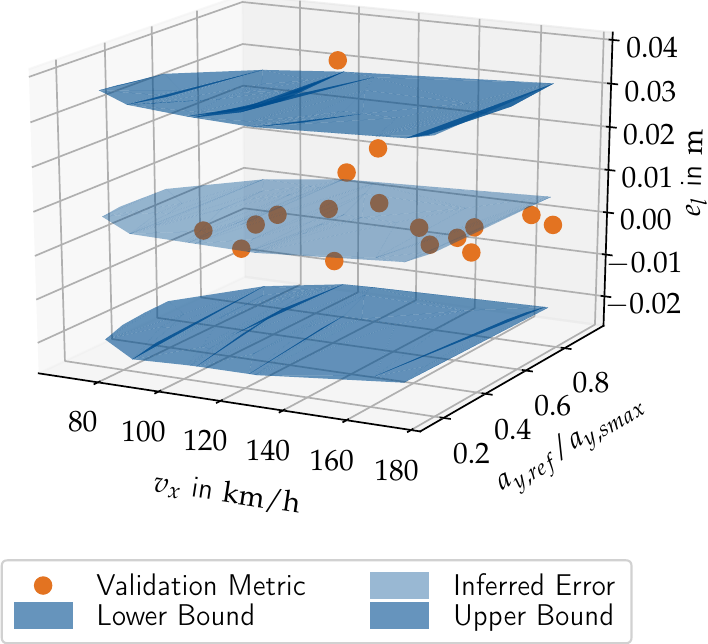
Figure 10. Validation errors, error regression estimates and additional prediction intervals. The left errors are used to parameterize the corresponding left linear regression